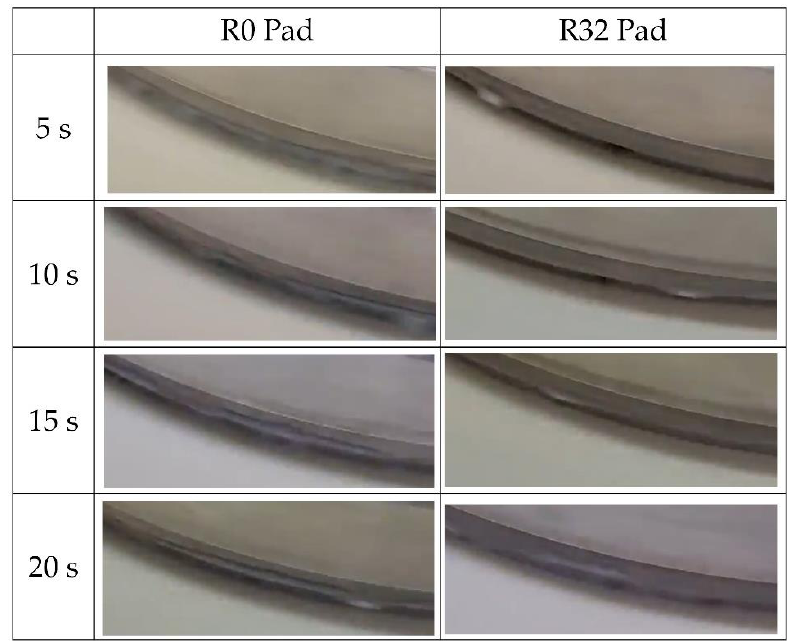
Figure 14. Bow wave images of the R0 pad and R32 pad along the polishing time.